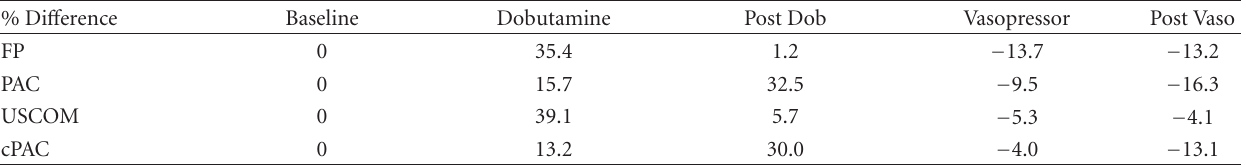
Table 2: Mean percentage change of CO from baseline (0%) at each intervention and recovery time-point in all sheep by each method. % Di ff erence